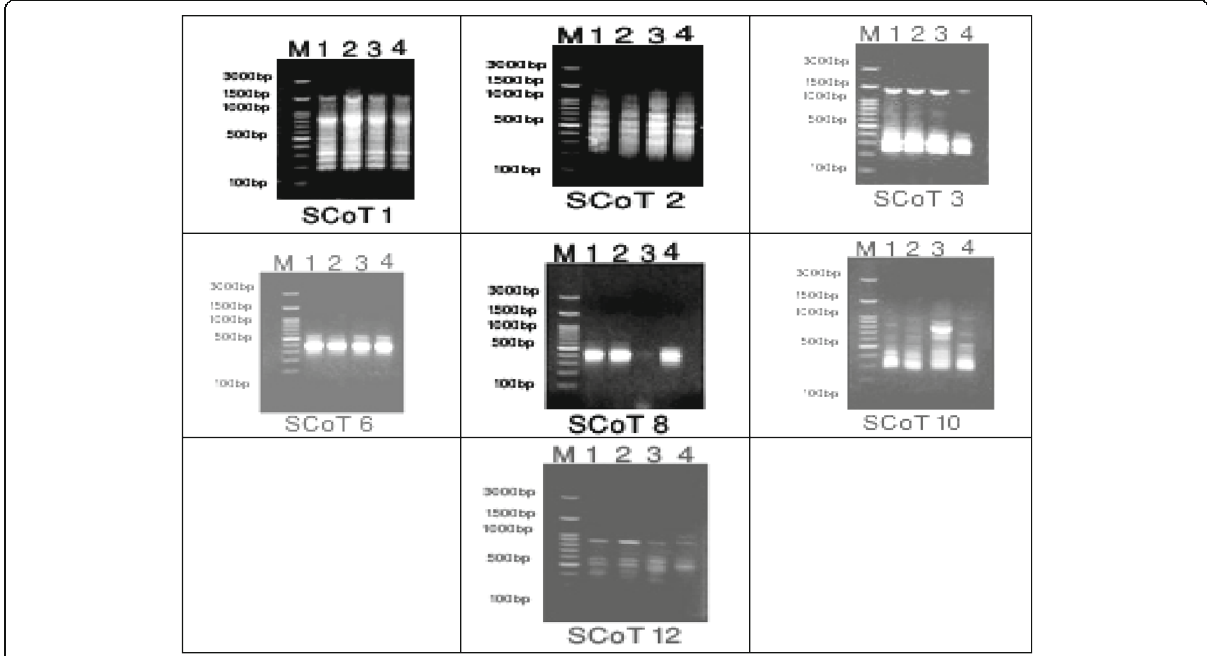
Fig. 4 The separation pattern of the SCoT products using seven primers. M: 100 bp ladder DNA marker. (1) control, (2) 15 min, (3) 30 min, and (4) 45 min. Exposure to UV,